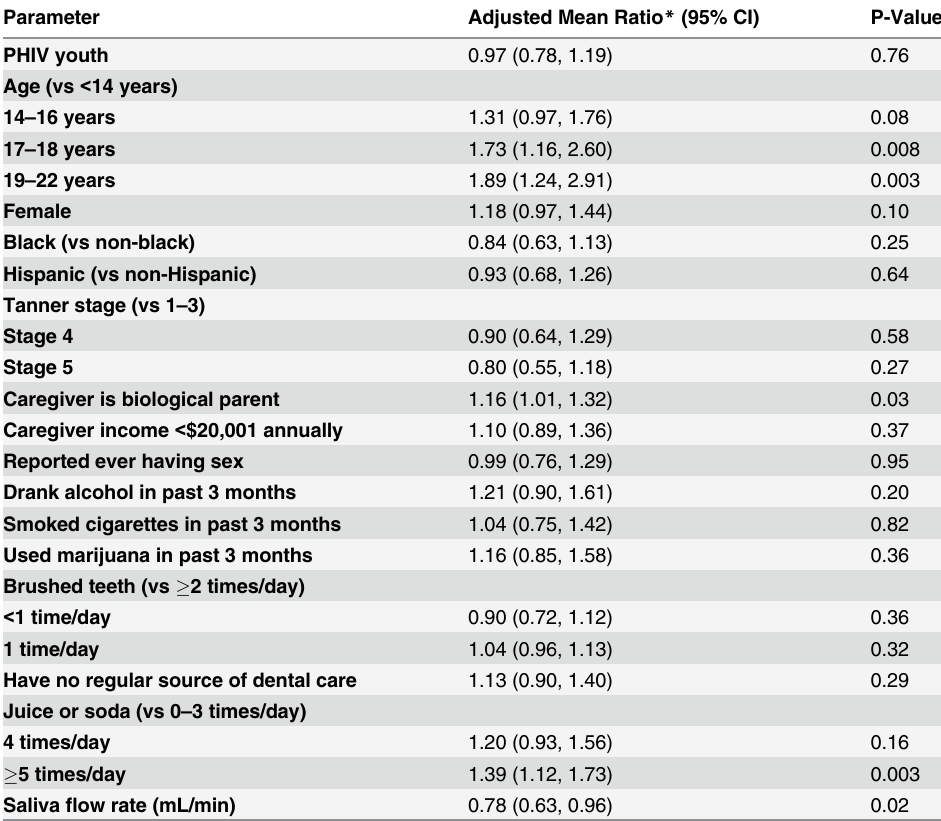
Table 4. Zero-inflated negative binomial multivariable model of decayed-missing-filled teeth (DMFT) score (N = 311).